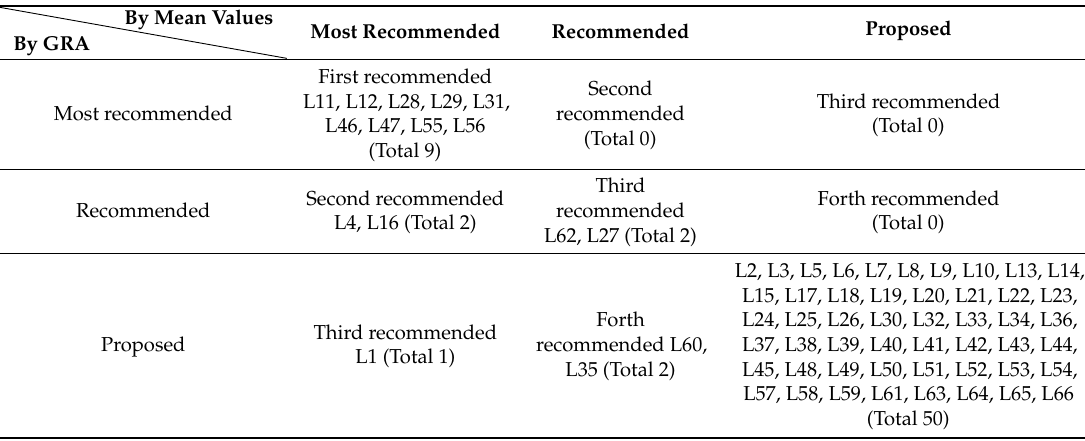
Table 5. The cross relationship of recommended pictures for LOHAS image by the two di ff erent